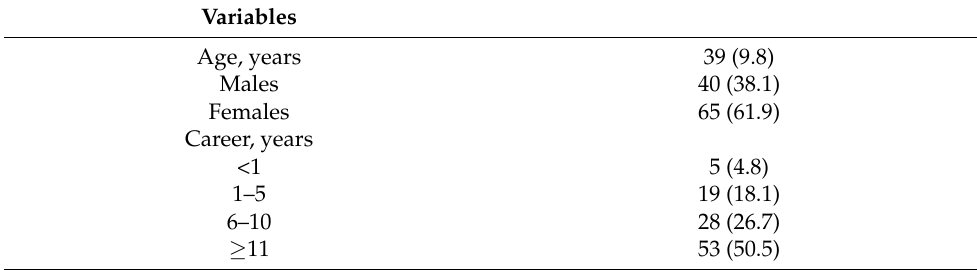
Table 1. Characteristics of the healthcare staff working in the